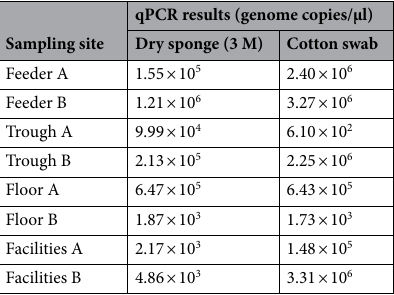
Table 2. Presence of African swine fever virus (ASFV) in environmental